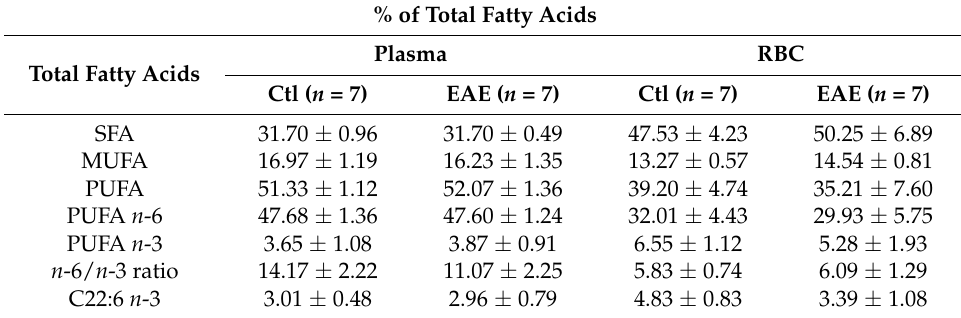
Data are presented as mean ± standard deviation (SD). SFA: saturated fatty acid; MUFA: monounsaturated fatty acid; PUFA: polyunsaturated fatty acids; n -6: omega-6; n -3: omega-3; C22:6 omega-3: